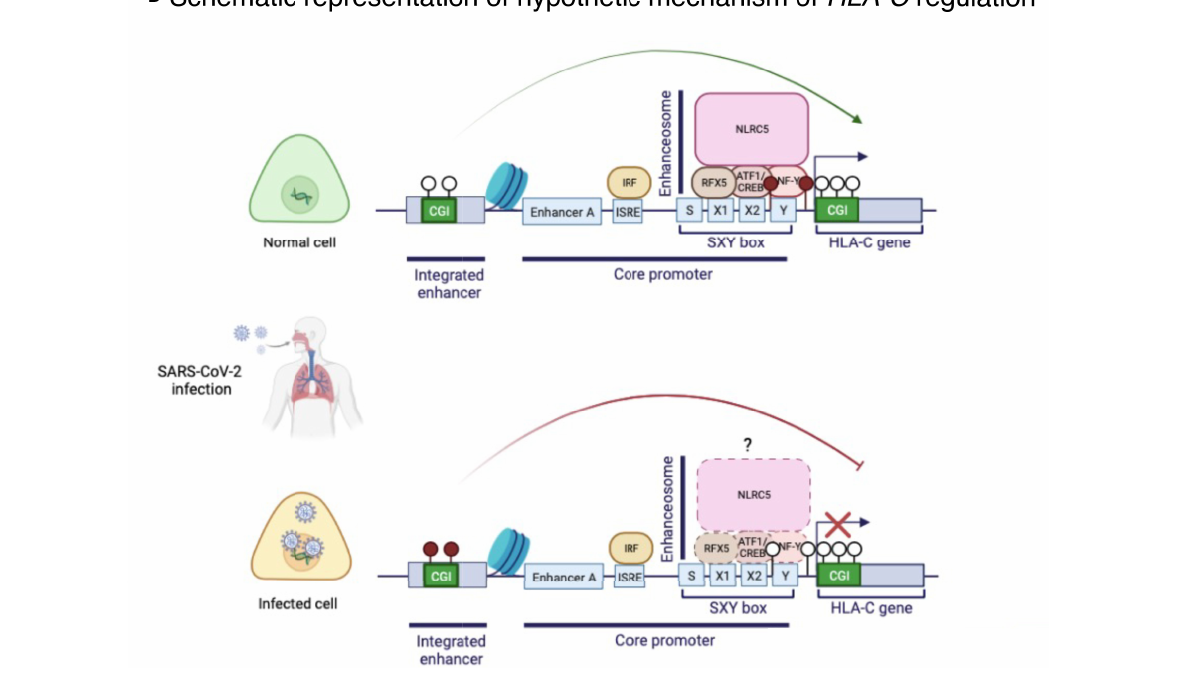
FIGURE 6 Potential altered mechanisms of HLA-C regulation in COVID-19 disease. (A) Integrated enhancers associated with HLA-C . (B) Integrated enhancer (chr6:31260493-31279454) associated with CGI chr6:31276241-31276526, found hypermethylated in COVID-19 patients. (C) Integrated enhancer (chr6:31240851-31241006) associated with S-shore region of CGI chr6:31238852-31240120, found hypomethylated in COVID-19 patients. (D) Schematic illustration of a possible mechanism of HLA-C downregulation observed in upper airway cells of COVID-19 patients. Lollipops are exempli fi cative representation of CpG sites, where empty and fi lled circles represent hypomethylated and hypermethylated CpG sites, respectively. Illustrations in panels A – C are from HACER database (http://bioinfo.vanderbilt.edu/AE/HACER/index. html); illustration in panel D was created with